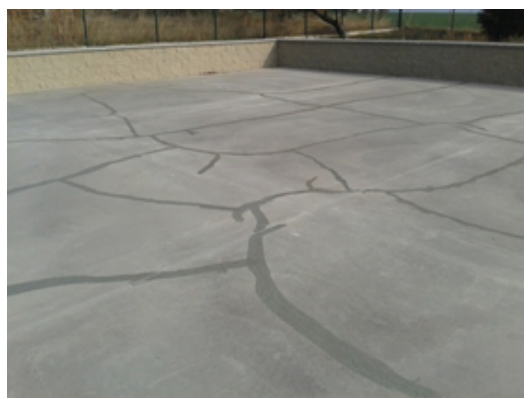
Figure 1. The example of cracks propagation due to